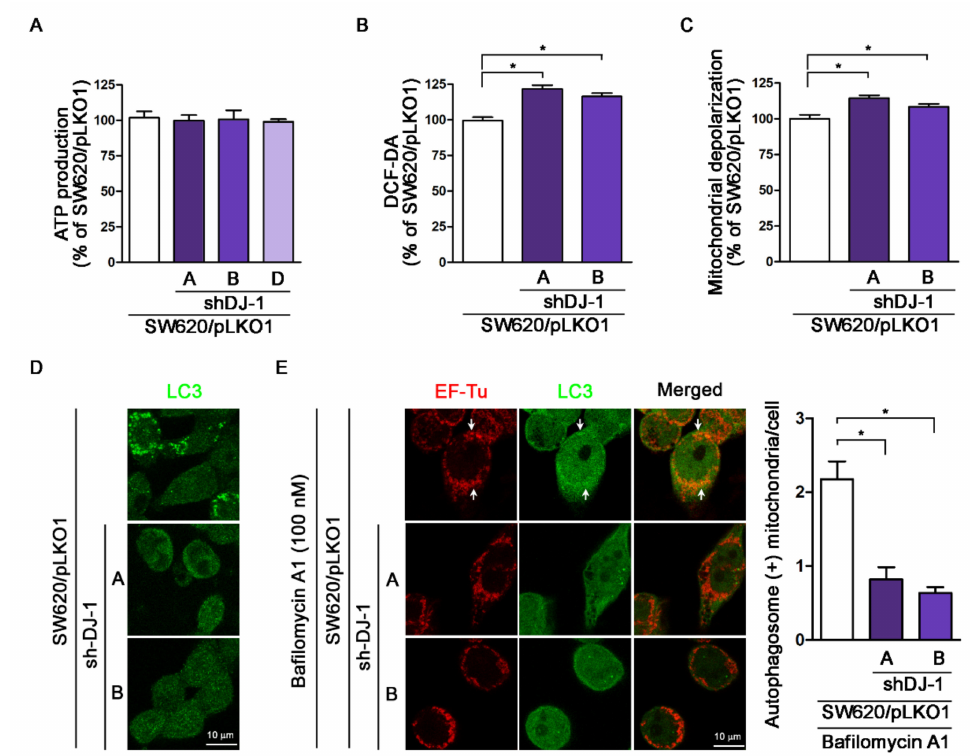
Figure 6. DJ-1 knockdown does not affect adenosine triphosphate (ATP) production; DJ-1 knockdown enhances intracellular reactive oxygen species (ROS) generation, damaged mitochondrial accumulation and mitophagy inhibition in metastatic colorectal adenocarcinoma cells. ( A ) The ATP production result shows that DJ-1 knockdown did not impact ATP production in three DJ-1 stable knockdown cell clones (SW620/pLKO1-shDJ-1-A, -B, and -D) as compared with control (SW620/pLKO1). ( B ) The DCF-DA assay result shows that DJ-1 knockdown cell clones (SW620/pLKO1-shDJ-1-A and -B) had higher intracellular ROS than control. ( C ) DJ-1 knockdown cell clones (SW620/pLKO1-shDJ-1-A and -B) showed increased mitochondrial depolarization than control. ( D ) For mitophagy analysis, we used anti-EF-Tu and anti-LC3 antibodies to stain mitochondria and autophagosomes, respectively. Images of LC3 immunofluorescence staining obtained from confocal microscopy show that control (SW620/pLKO1) cells contained more autophagosomes (LC3 punctate dots) than DJ-1 knockdown cell clones (SW620/pLKO1-shDJ-1-A and -B). ( E ) Images of immunofluorescence double staining obtained from confocal microscopy show mitochondria colocalized with autophagosomes in control (SW620/pLKO1). Arrows indicate the colocalizations of EF-Tu and LC3. DJ-1 knockdown cell clones (SW620/pLKO1-shDJ-1-A and -B) inhibited mitochondria colocalization with autophagosomes. These results indicate that DJ-1 knockdown does not influence mitochondrial ATP production but enhances intracellular ROS generation and damaged mitochondria accumulation and inhibits mitochondria colocalization with autophagosomes. The quantification data of autophagosome-positive mitochondria per cell are shown on the right panel. Data are expressed as the means ± S.E.M; the p -value was determined by one-way ANOVA/Newman–Keuls test. * p < 0.05 compared with the control